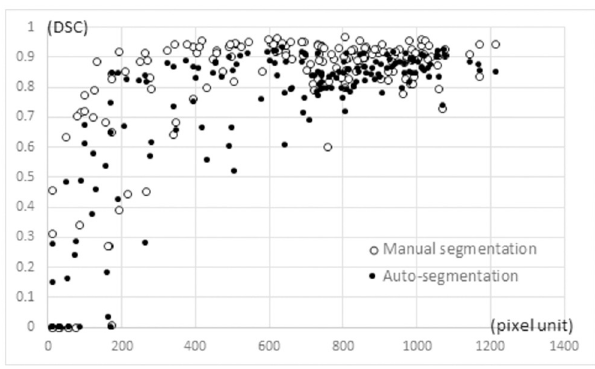
Fig 3. Scatter plot of CSA (unit: Pixels) and DSC in the model validation datasets.